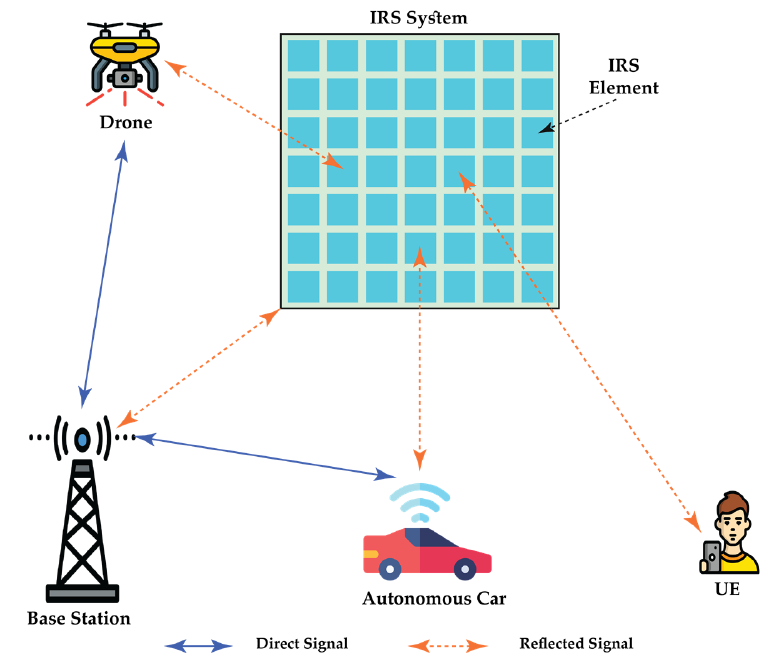
Figure 8. Intelligent Reflecting